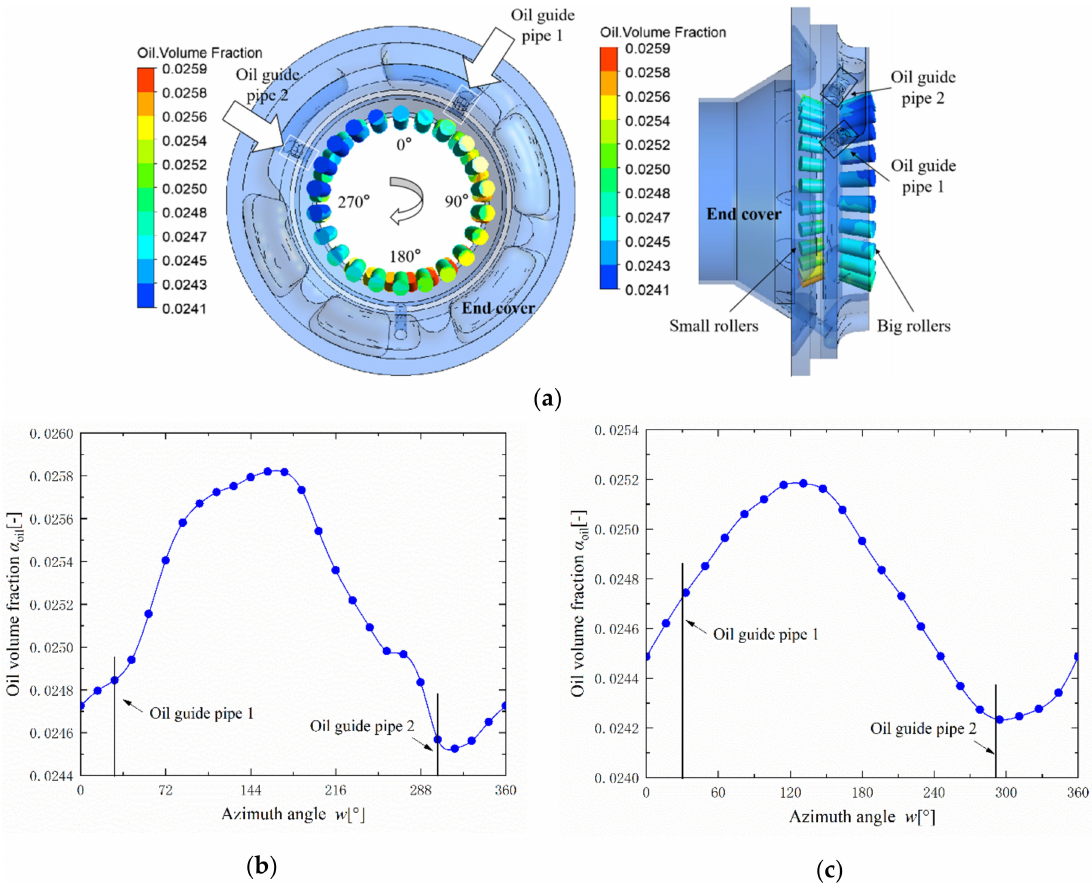
Figure 16. Lubrication characteristics of bearing rollers: ( a ) azimuth angle of rollers; ( b ) oil volume fraction of small rollers; ( c ) oil volume fraction of big rollers.